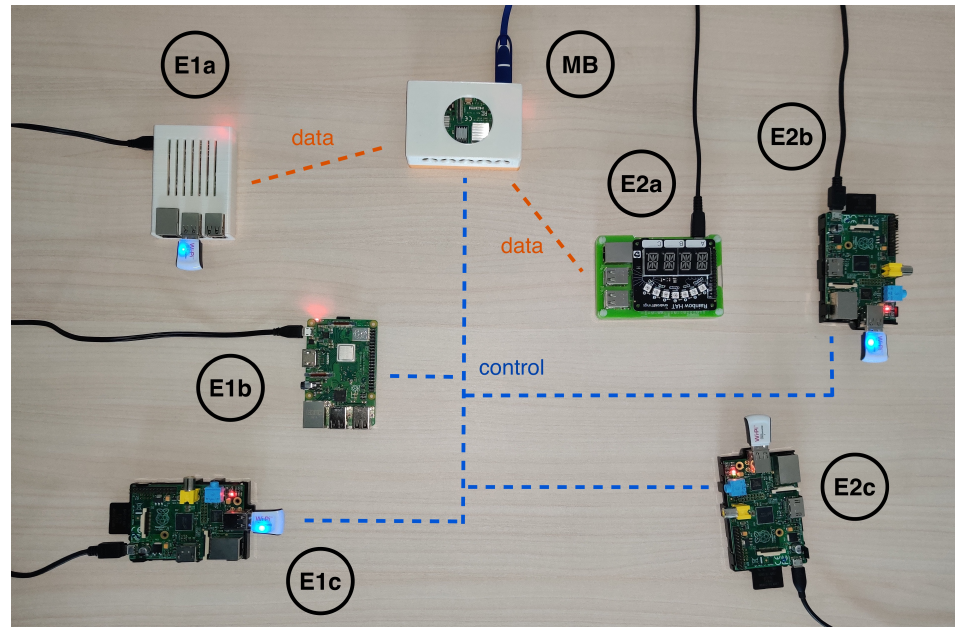
Figure 3. Message Broker/Orchestrator and Edge devices in the platform